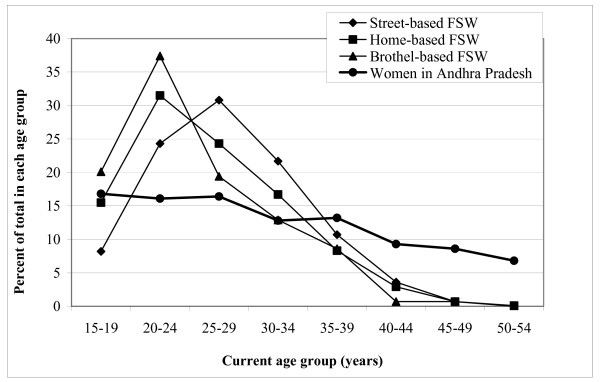
Age distribution of female sex workers and of women aged 15 to 54 years in the state of Andhra Pradesh, India [11]. For female sex workers (FSWs), the age category of 15–19 years denotes 16–19 years.